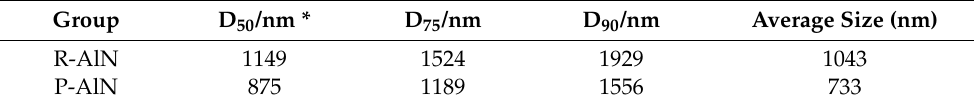
Table 3. Particle size distribution of AlN powder in water-based system. Group